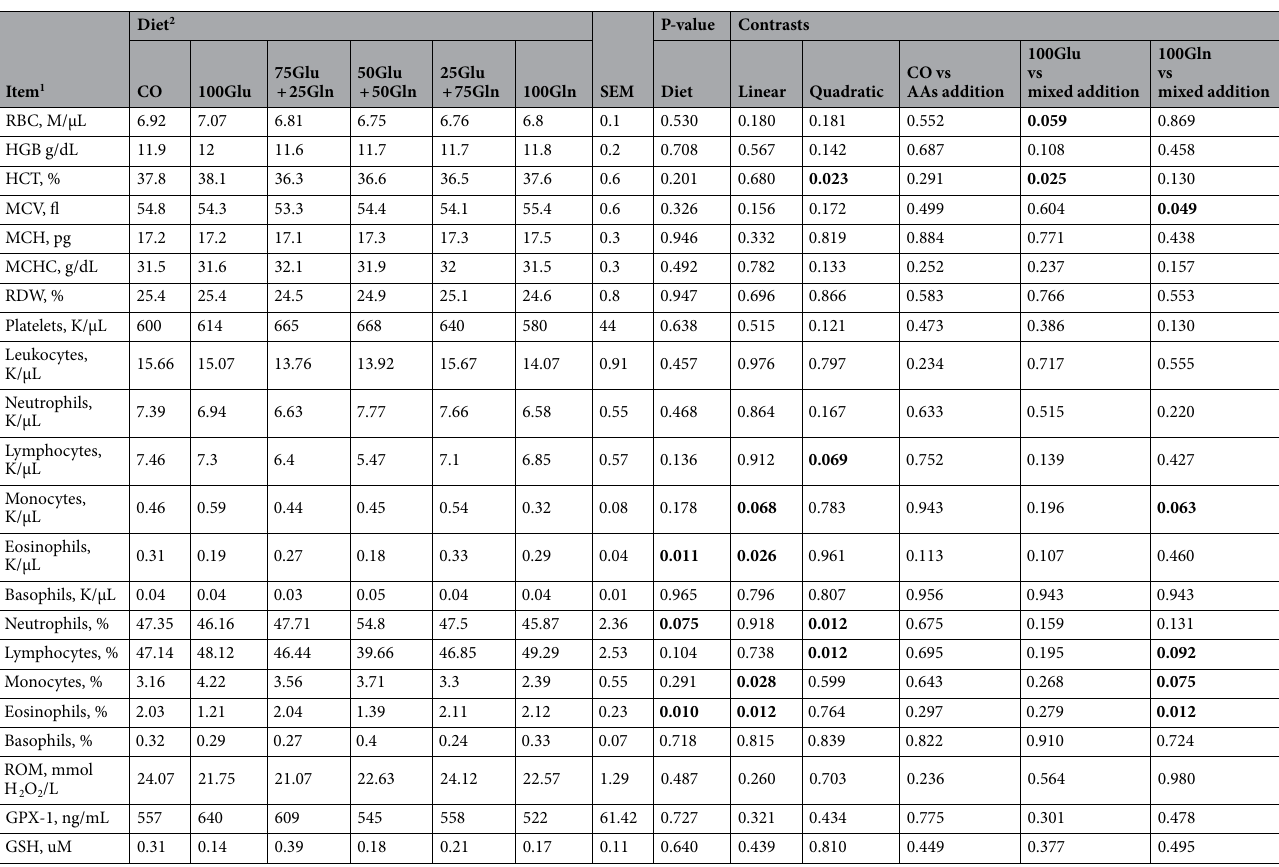
Table 2. Effect of the dietary supplementation (6 kg/T) with glutamate and glutamine in different ratio on haematological parameters of piglets at 8 days post-weaning. 1 RBC, red blood cells, HGB, haemoglobin, HCT, haematocrit, MCV, mean corpuscular volume, MCH, mean corpuscular haemoglobin, MCHC, mean corpuscular haemoglobin concentration, RDW, red cell distribution width. Diet 2 CO = standard diet; 100Glu = CO plus 6 kg/Ton Glu; 75Glu + 25Gln = CO plus 4.5 kg/Ton Glu and 1.5 kg/Ton Gln; 50Glu + 50Gln = CO plus 3 kg/Ton Glu plus 3 kg/Ton Gln; 25Glu + 75Gln = CO plus 1.5 kg/Ton Glu and 4.5 kg/ Ton Gln; 100Gln = CO plus 6 kg/Ton Gln. Significant values are in